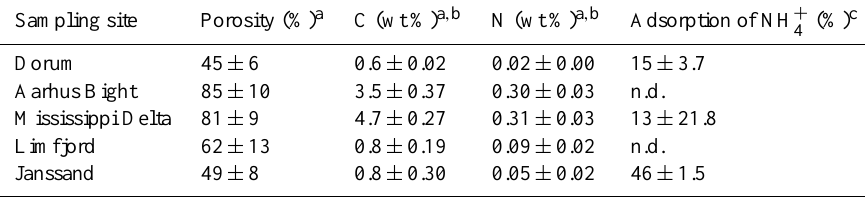
Table 2. Sediment